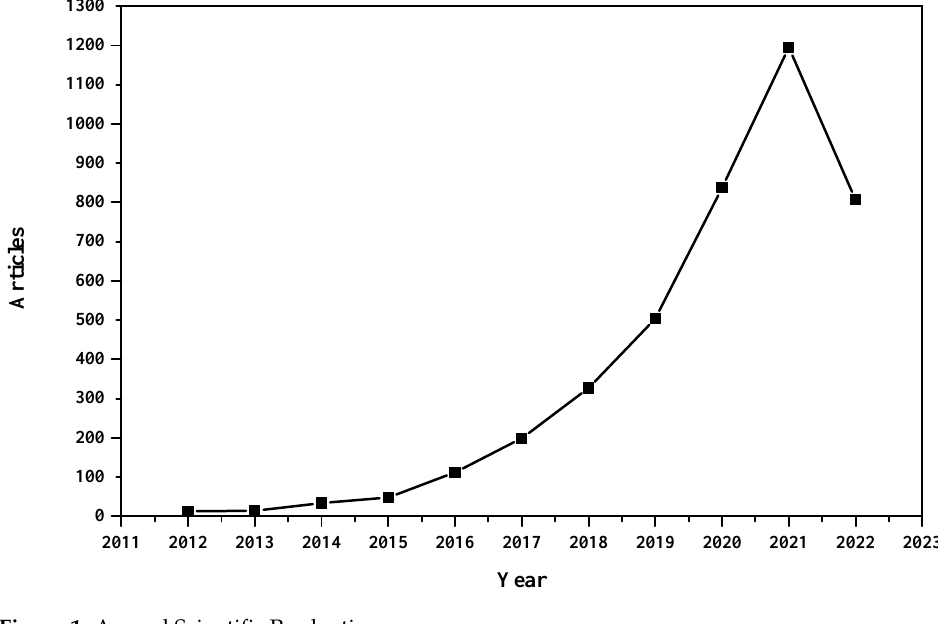
Figure 1. Annual Scientific Production.